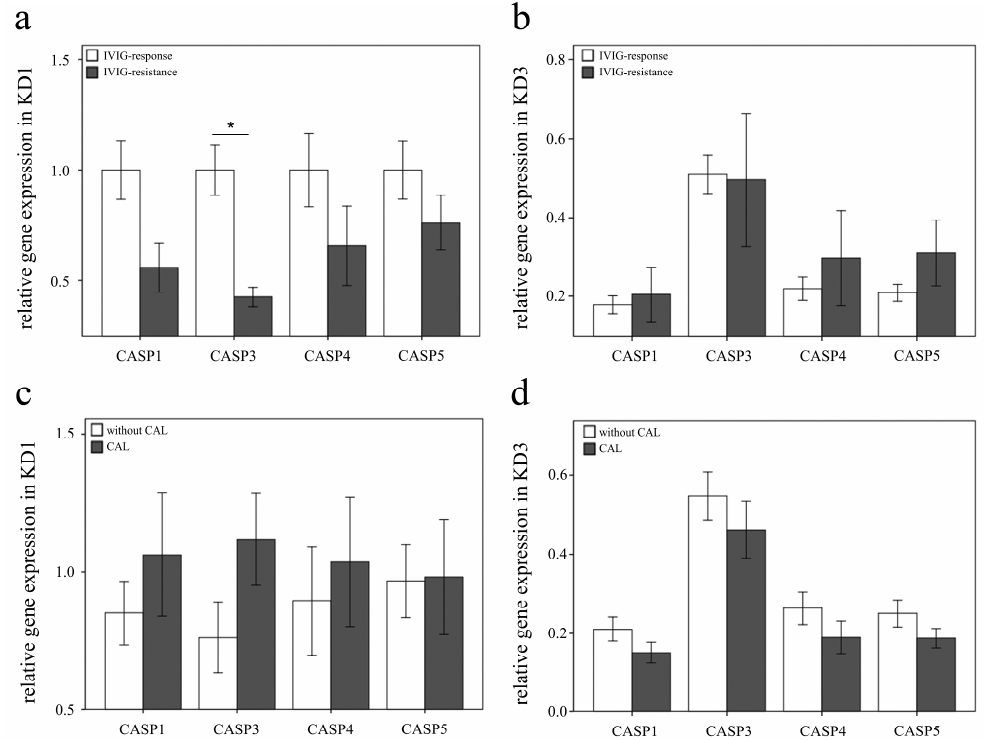
Figure 4. The relationship of the expressions of CASP1, CASP3, CASP4, and CASP5 analyzed in intravenous immuno- globin (IVIG) response ( a , b ) and coronary artery lesions (CAL) formation ( c , d ) respectively in peripheral leukocytes of 46 Kawasaki disease (KD) patients, using a real-time quantitative polymerase chain reaction. Data analyzed by one way ANOVA and Fisher’s LSD multiple comparisons. * indicates significance ( p < 0.05) between the groups. KD1: Kawasaki disease before IVIG treatment; KD3: Kawasaki disease > 3 weeks after IVIG treatment.